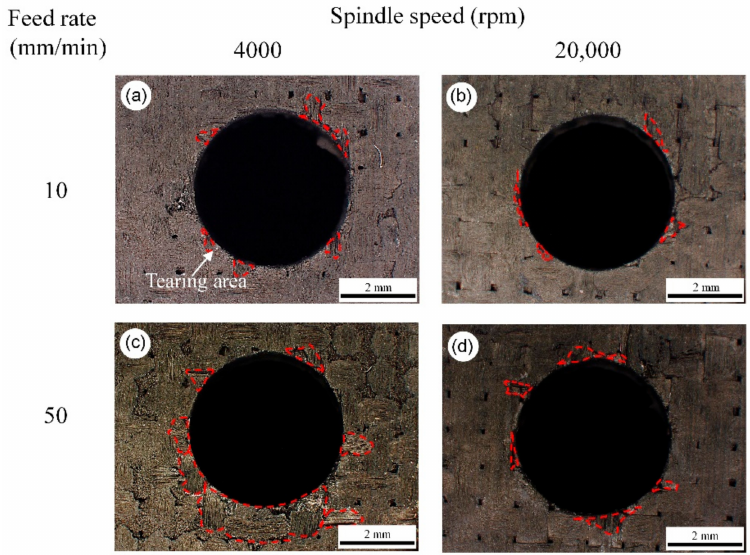
Figure 16. The morphology of the hole exit tearing areas in CD with ( a ) n = 4000 rpm, v w = 10 mm/min; ( b ) n = 20,000 rpm, v w = 10 mm/min; ( c ) n = 4000 rpm, v w = 50 mm/min; ( d ) n = 20,000 rpm, v w = 50